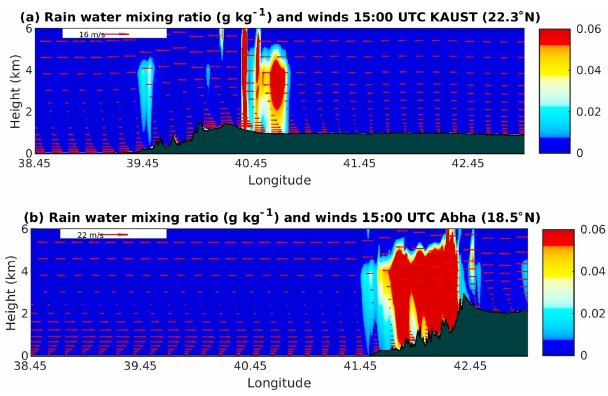
Figure 9. Rainwater mixing ratio and wind vectors averaged at 15:00UTC over the study period (4–31 August 2015) at two lon- gitudinal cross sections passing through (a) KAUST and (b) Abha.